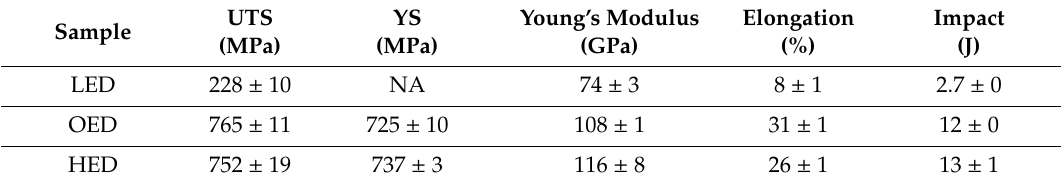
Table 3. Mechanical properties of SEBAMed Ti6Al4V in varying energy